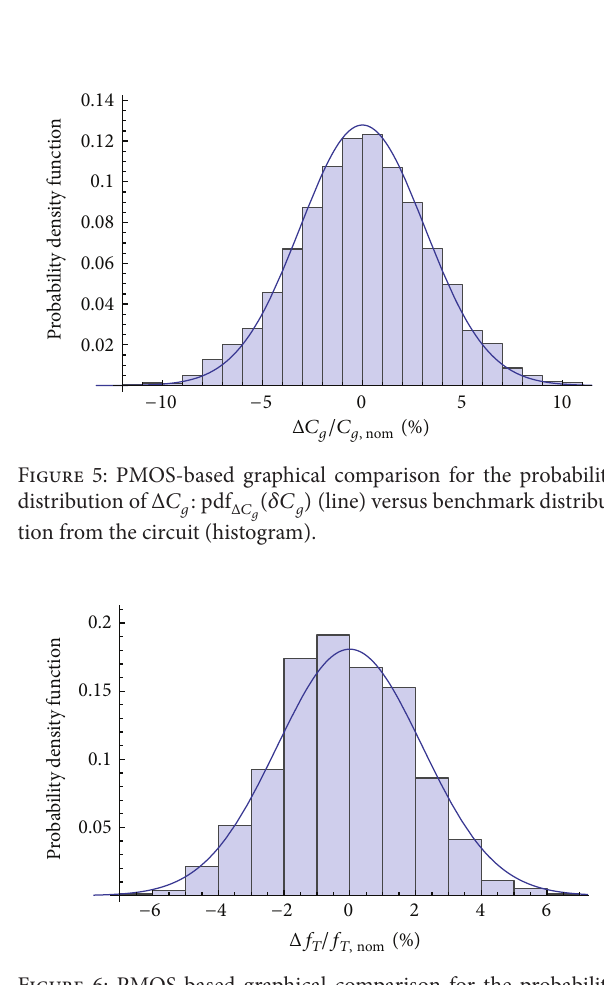
(𝛿𝑓 ) (line) versus benchmark distribu- 𝑇 𝑇